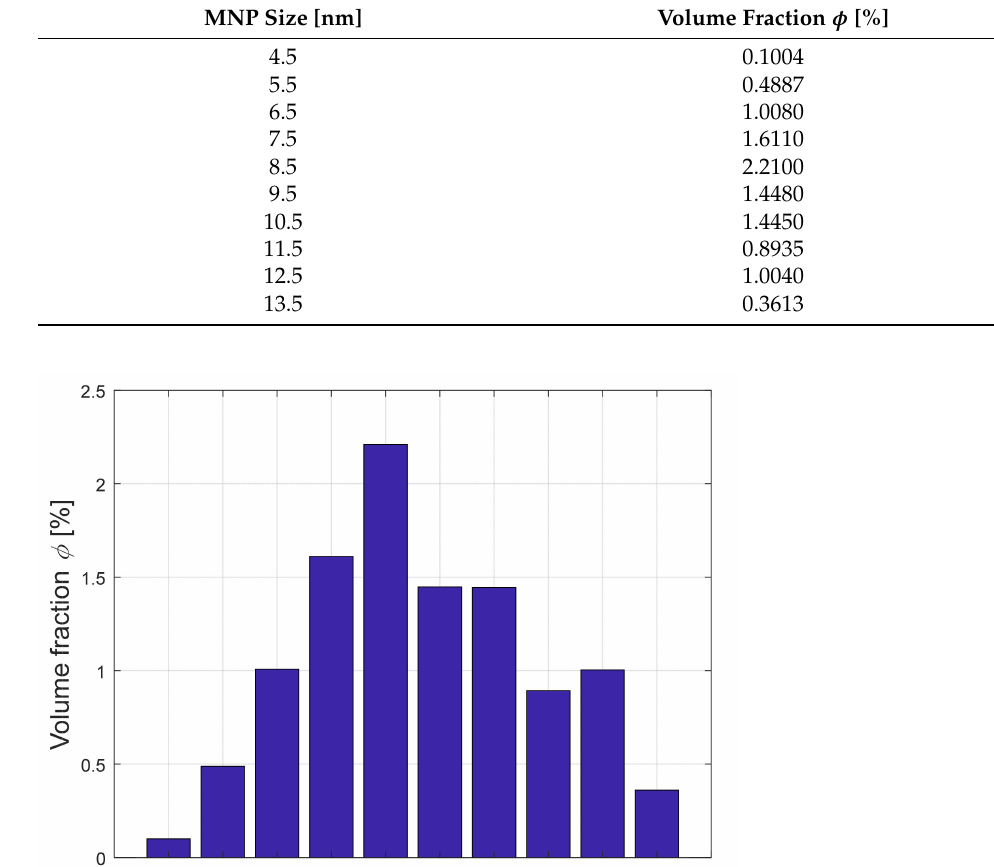
Table 1. Groups of different sized magnetic nanoparticles (MNPs) with corresponding volume fractions.